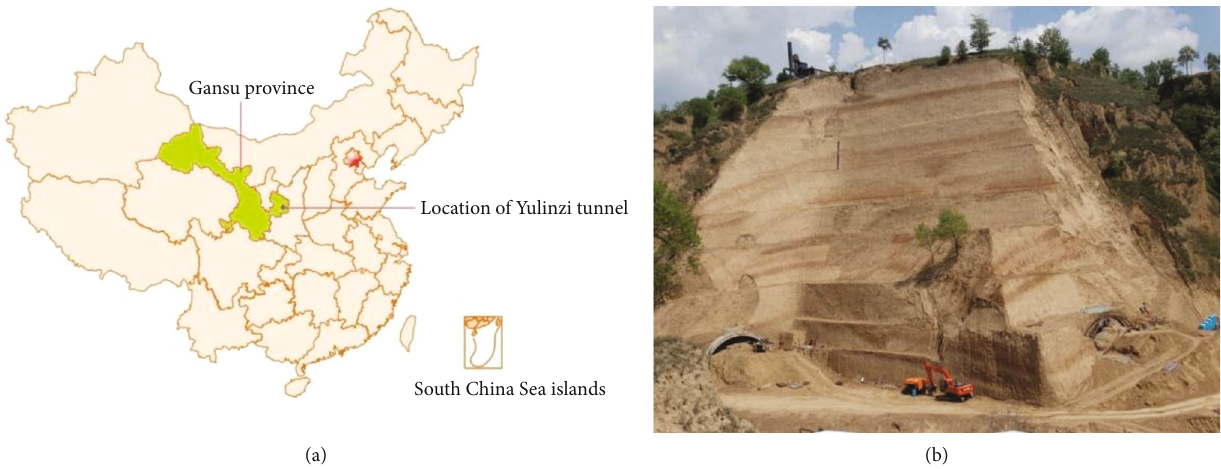
Figure 1: Location and surrounding geological conditions of Yulinzi